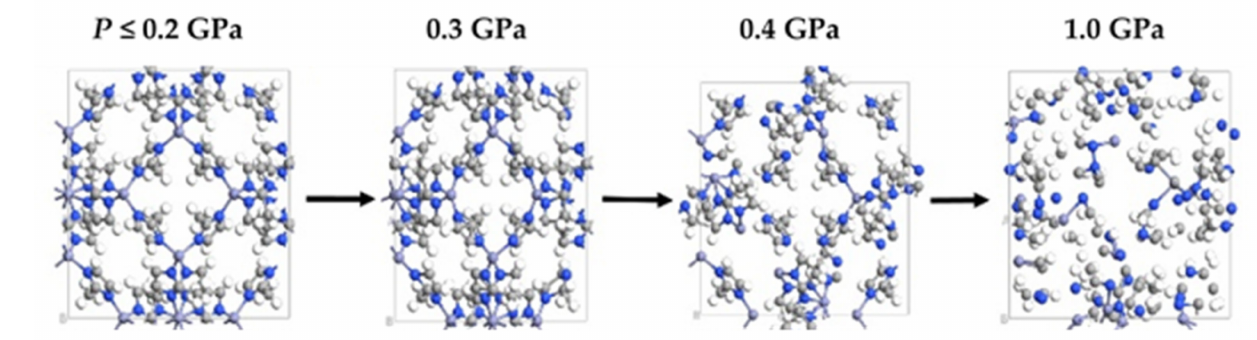
Figure 4. SOD-Zn(HMeIm) 2 atomic structure at different applied, uniform